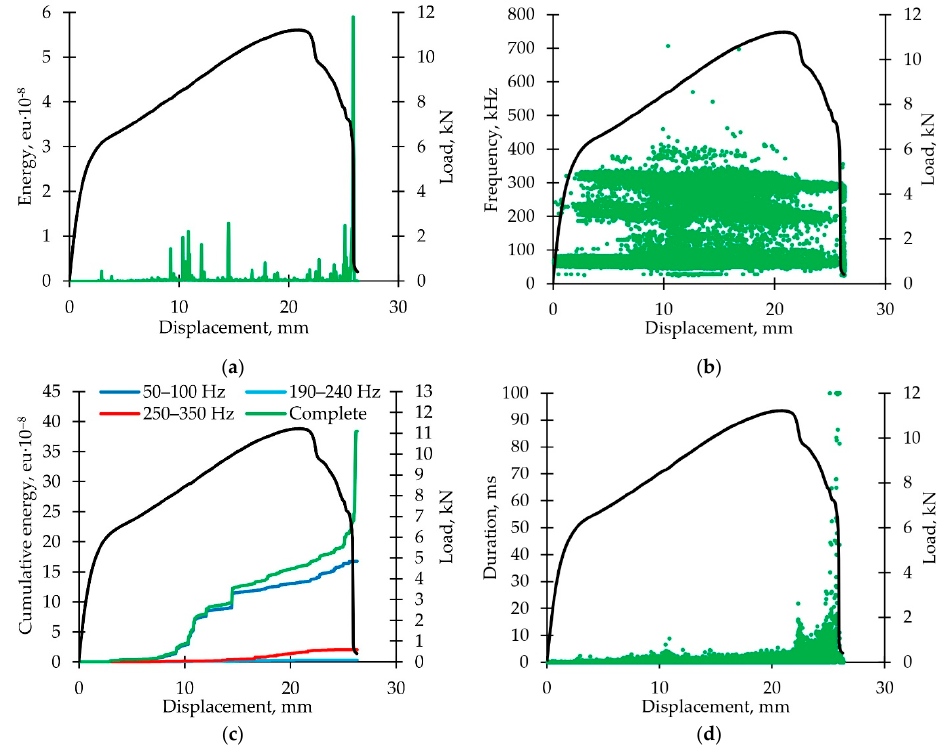
Figure 5. Analysis of acoustic emission signals (active loading): ( a ) Typical distribution diagram for the energy parameter of AE signals versus displacement; ( b ) typical distribution diagram of AE signals frequency parameter versus displacement; ( c ) typical diagram of cumulative energy depend- ence on displacement for various AE signals frequencies; ( d ) typical distribution diagram of AE signals durability parameter versus displacement. All the diagrams are accompanied by load dia- gram.